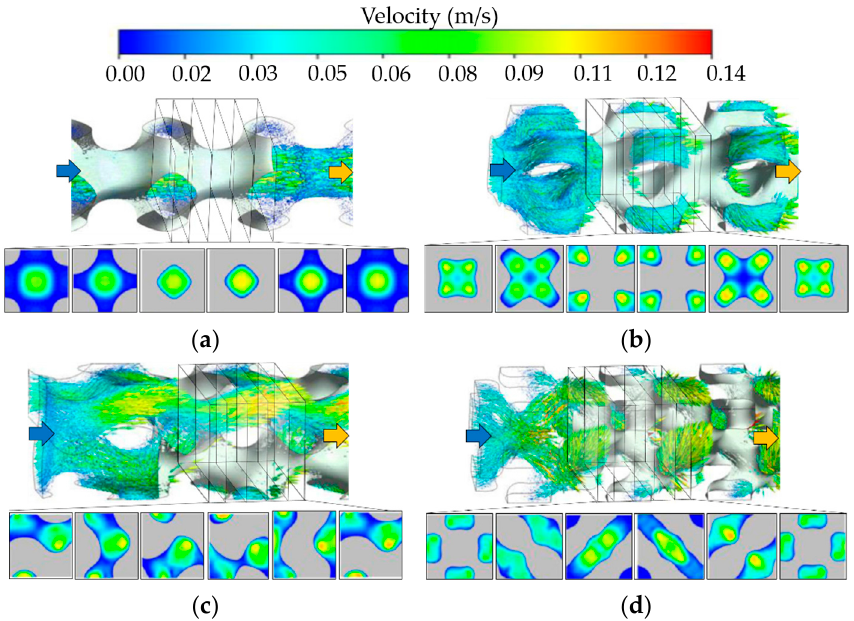
Figure 6. Velocity fields for different TPMS structures with the same porosity at the mass flow rate of 2.5 kg/s 2 (More flow details are provided by Cheng et al. [65]): ( a ) Sheet-Primitive; ( b ) Sheet-IWP; ( c ) Sheet-Gyroid; ( d ) Sheet-Diamond structures.